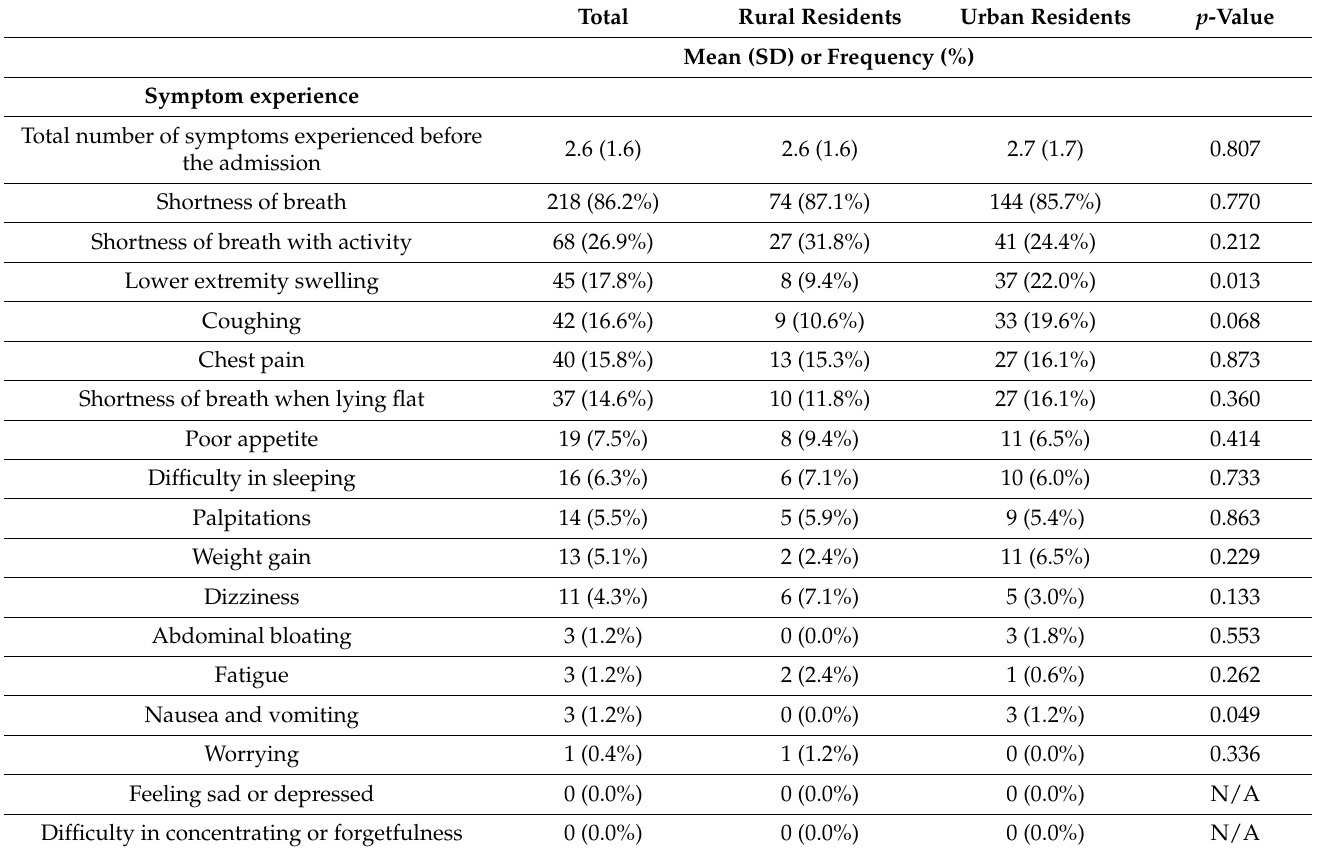
Figure 1. Distribution of the pre-hospital delay in seeking medical care (N = 253). Table 2. Patients’ experiences before the index hospitalization (N = 253).